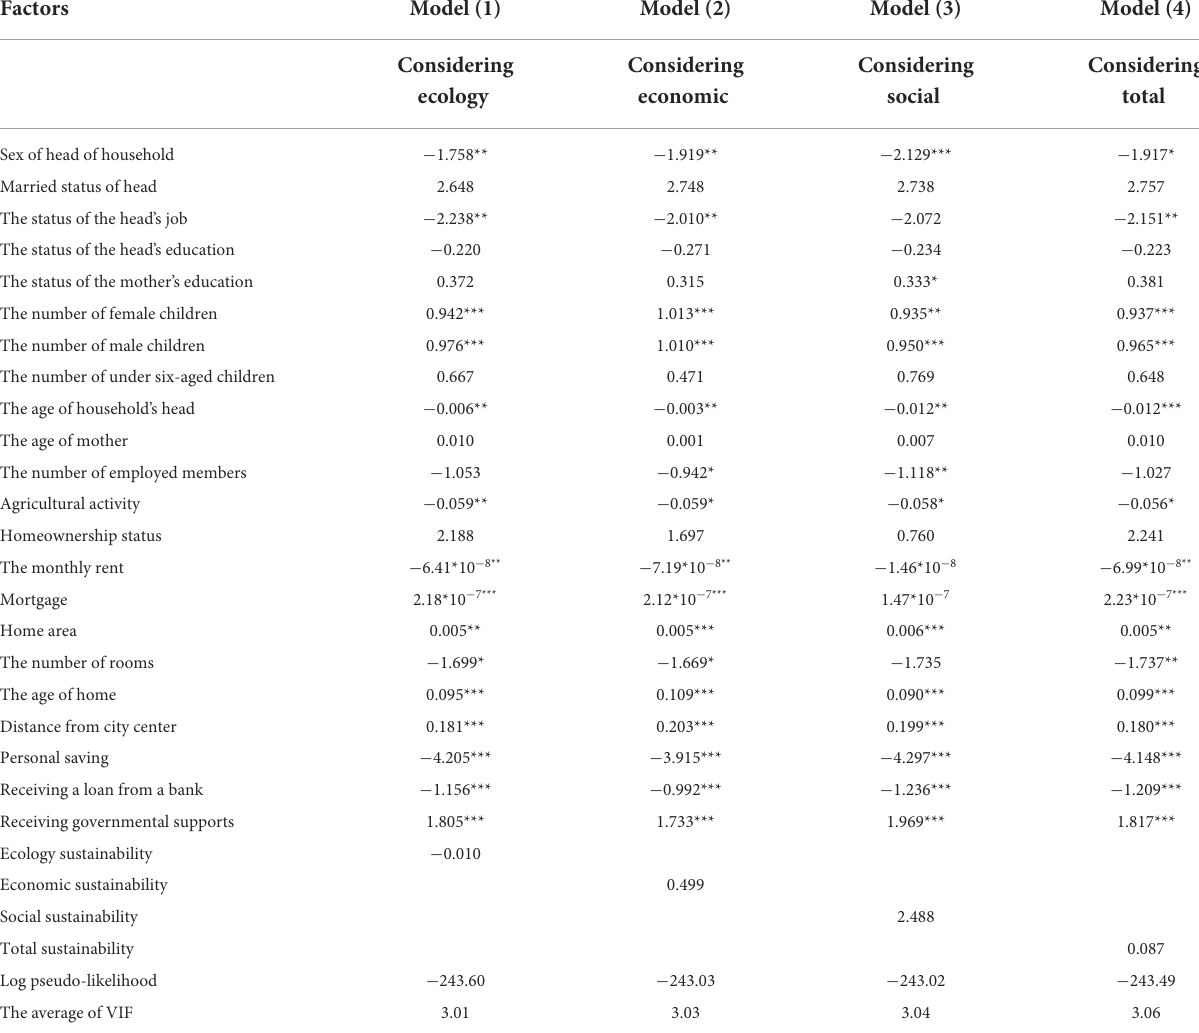
TABLE 8 The results of censored regression (Tobit model) of households’ food insecurity. Factors Model (1) Model (2) Considering Considering Considering Considering ecology economic